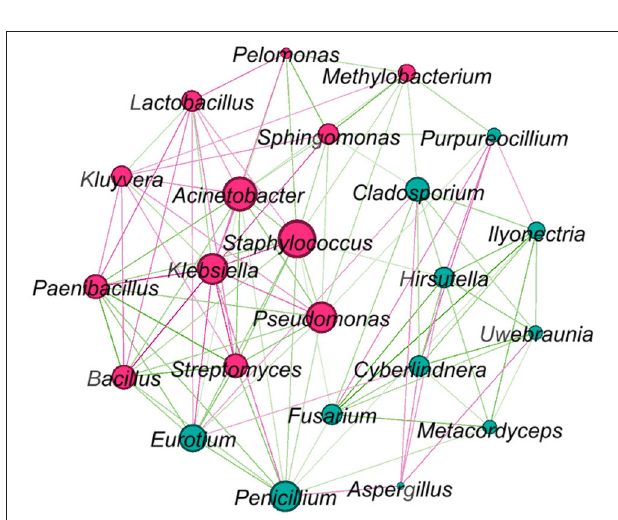
FIGURE 5 | Network graph showing relationships between core microbes (bacteria and fungi) presented in Table 2 . Larger nodes indicate higher connections with other genera. Red connections indicate negative correlations, while green connections indicate positive correlations. Pink nodes indicate bacterial genera and green nodes indicate fungal